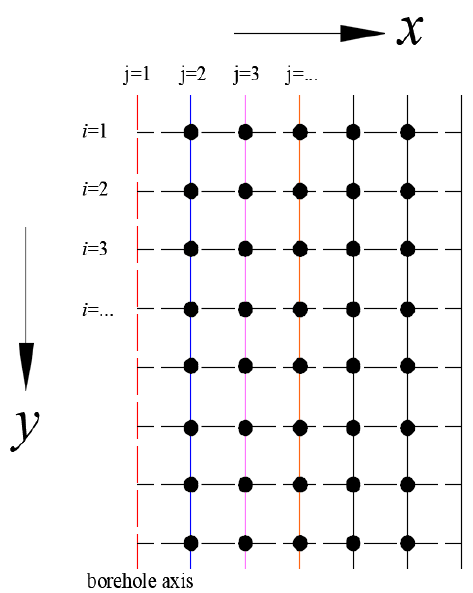
Figure A1. Schematic diagram of mesh grids of wellbore and formation.